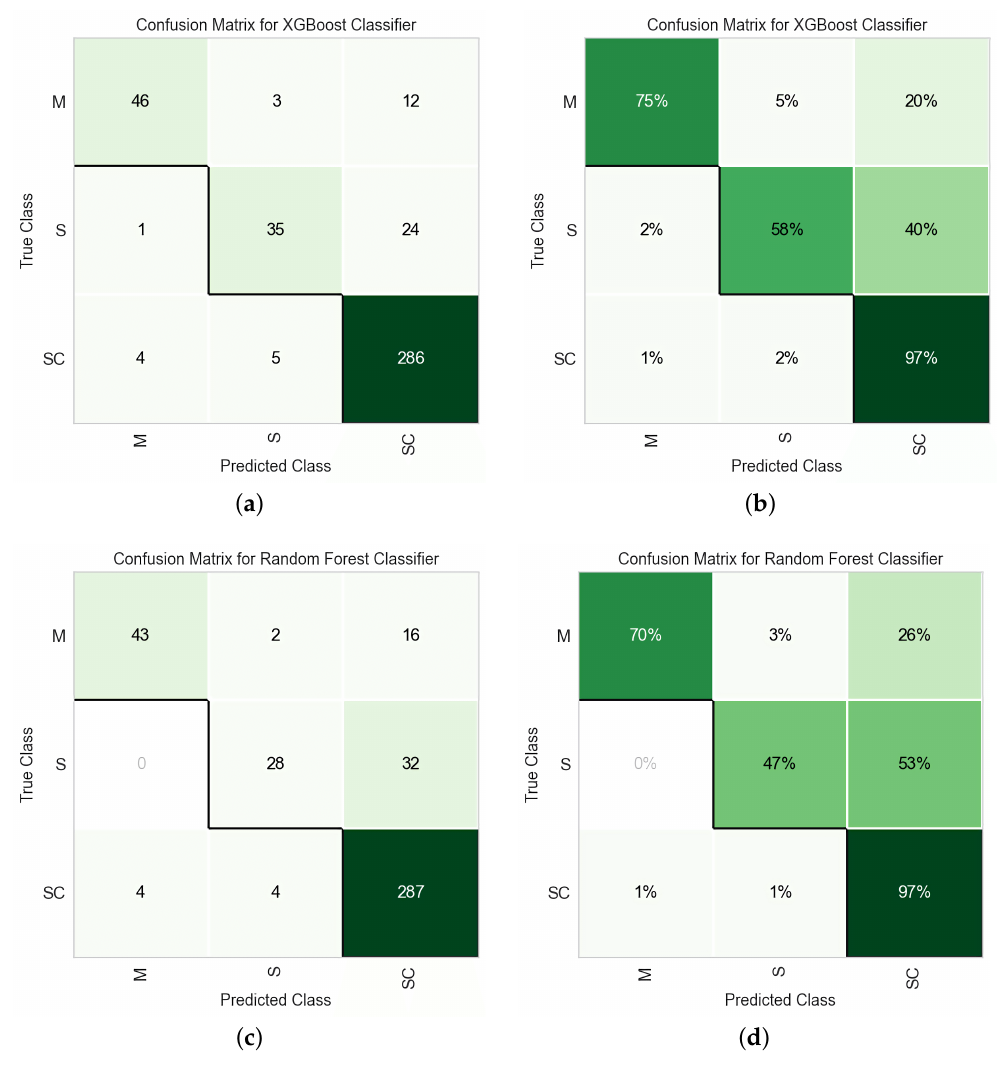
Figure 3. Confusion Matrices for XGBoost (first row) and RF (second row). ( a , c ) represents the number of true and predicted lithology classes; ( b , d ) highlight the percentage of true and predicted normalized per lithology